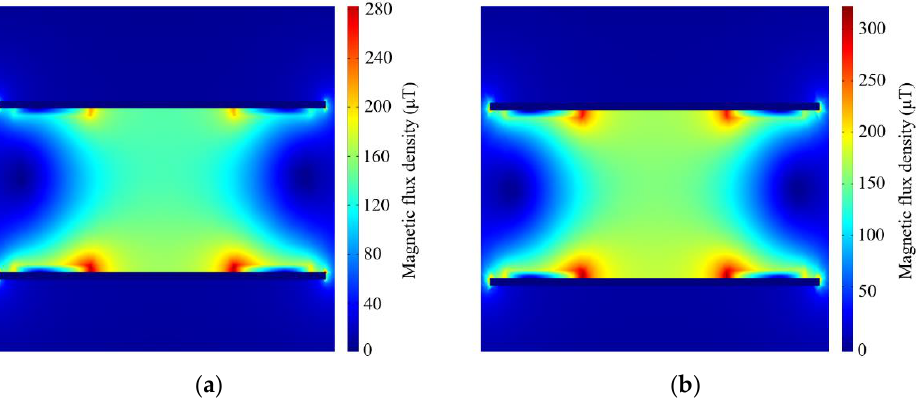
Figure 7. Simulation results of spatial magnetic field distribution in x – y plane: ( a ) ferrite shield and ( b ) composite material shield.